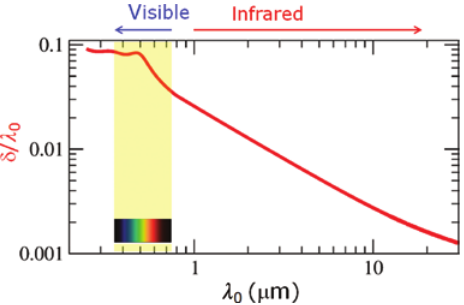
Figure 1: Spectral dependence of the skin depth of